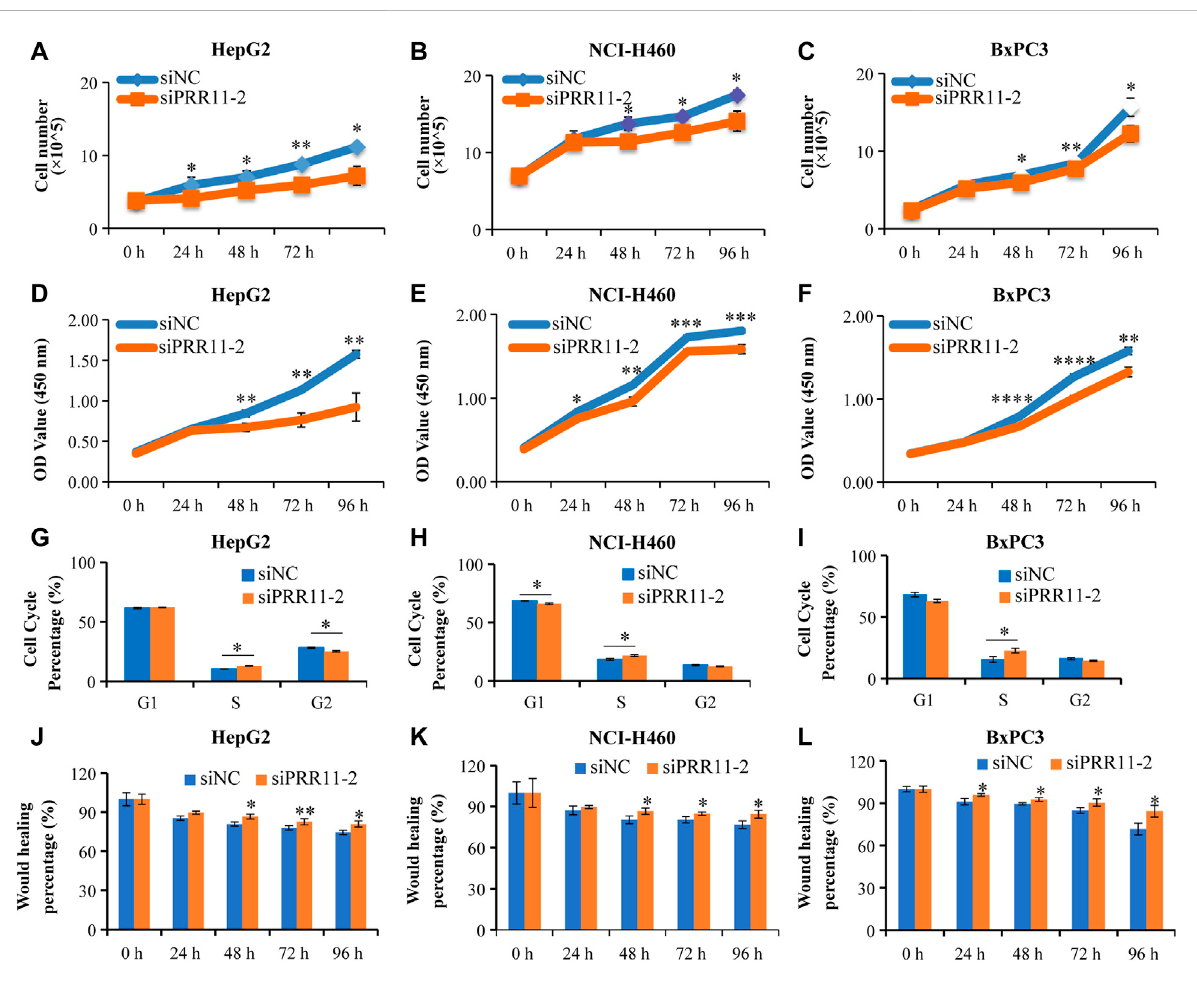
FIGURE 2 The low expression level of PRR11 strikingly inhibit tumor cell proliferation and migration. (A-C) Cell number of HepG2, NCI-H460, and BxPC3 after treating with siNC and siPRR11, respectively. (D-F) CCK-8 result of HepG2, NCI-H460, and BxPC3 after treating with siNC and siPRR11, respectively. (G-I) Cell cycleofHepG2,NCI-H460, and BxPC3 aftertreating with siNC andsiPRR11,respectively. (J-L) CellmigrationofHepG2,NCI- H460, and BxPC3 after treating with siNC and siPRR11, respectively. * p < 0.05, ** p < 0.01, *** p < 0.001, and **** p <